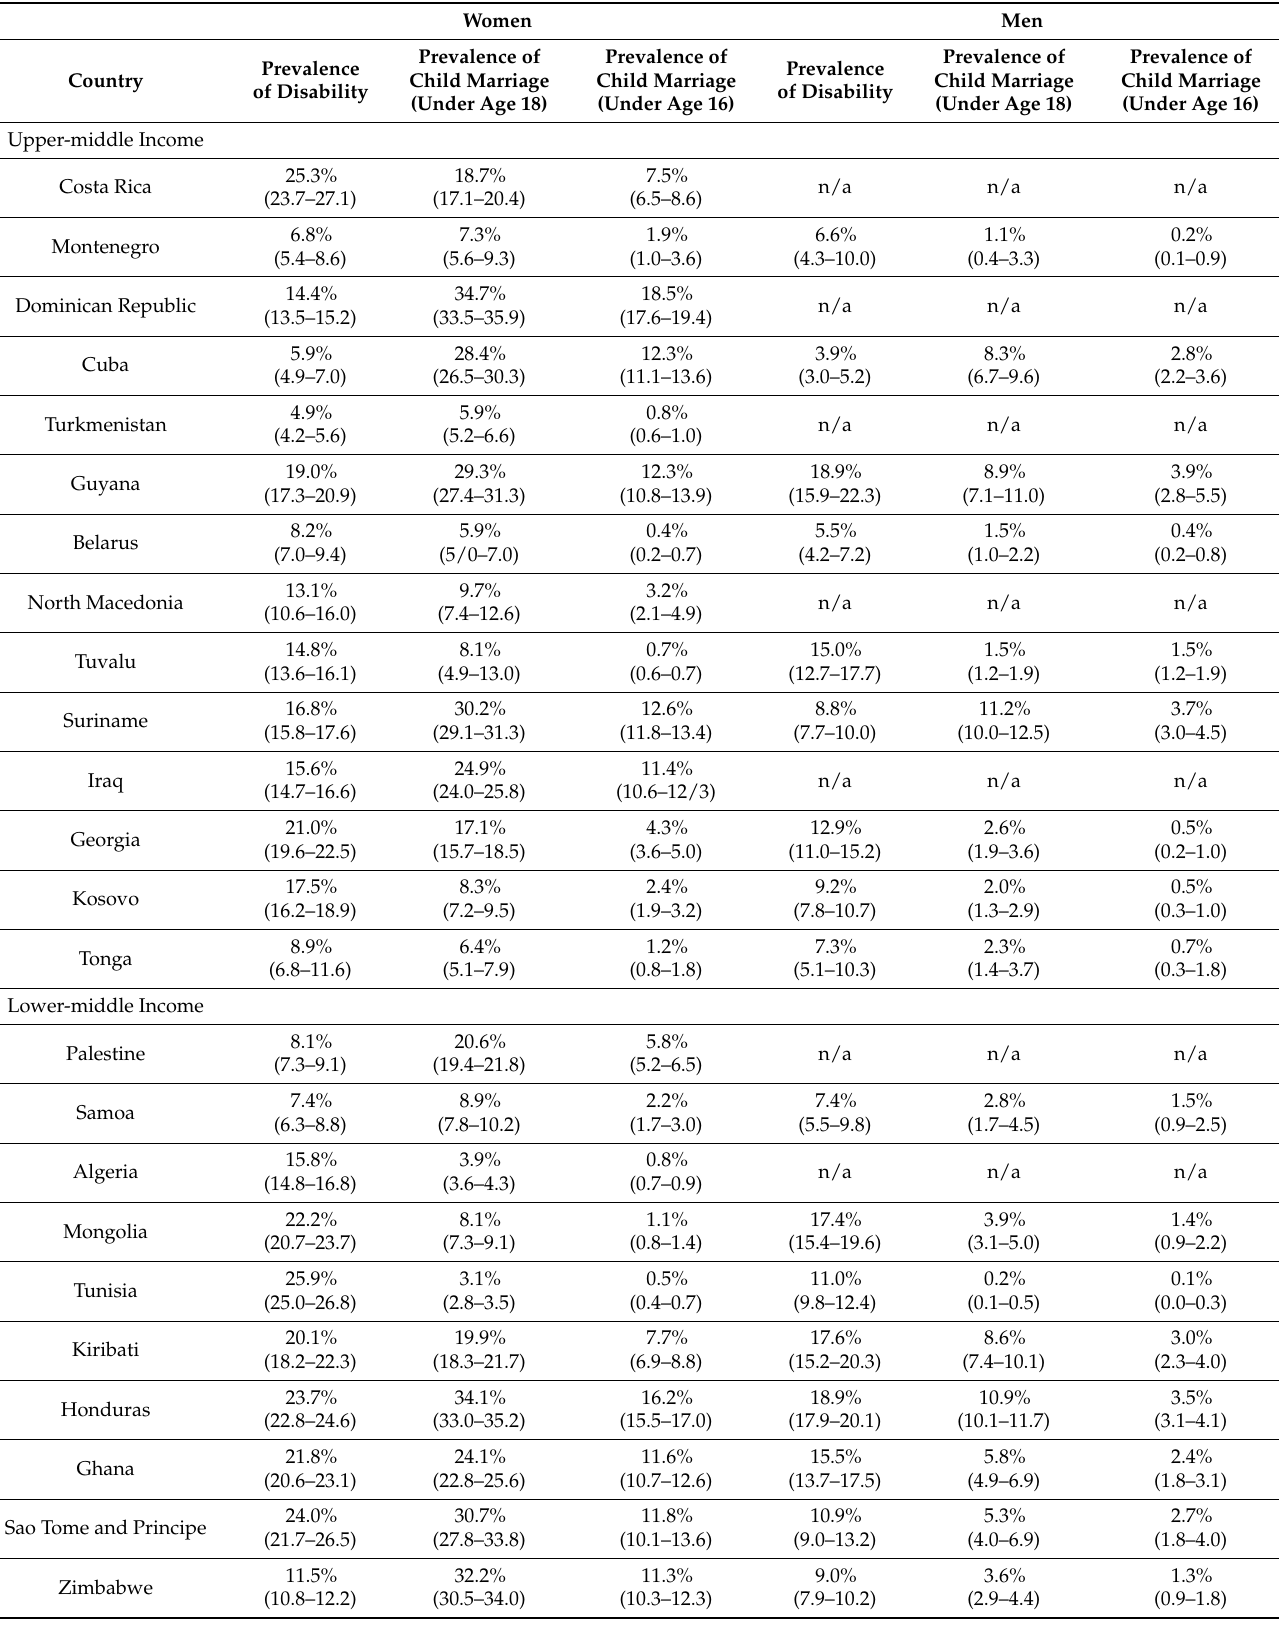
Table 2. Country-level estimates of the prevalence of disability and of child marriage in 37 middle- and low-income